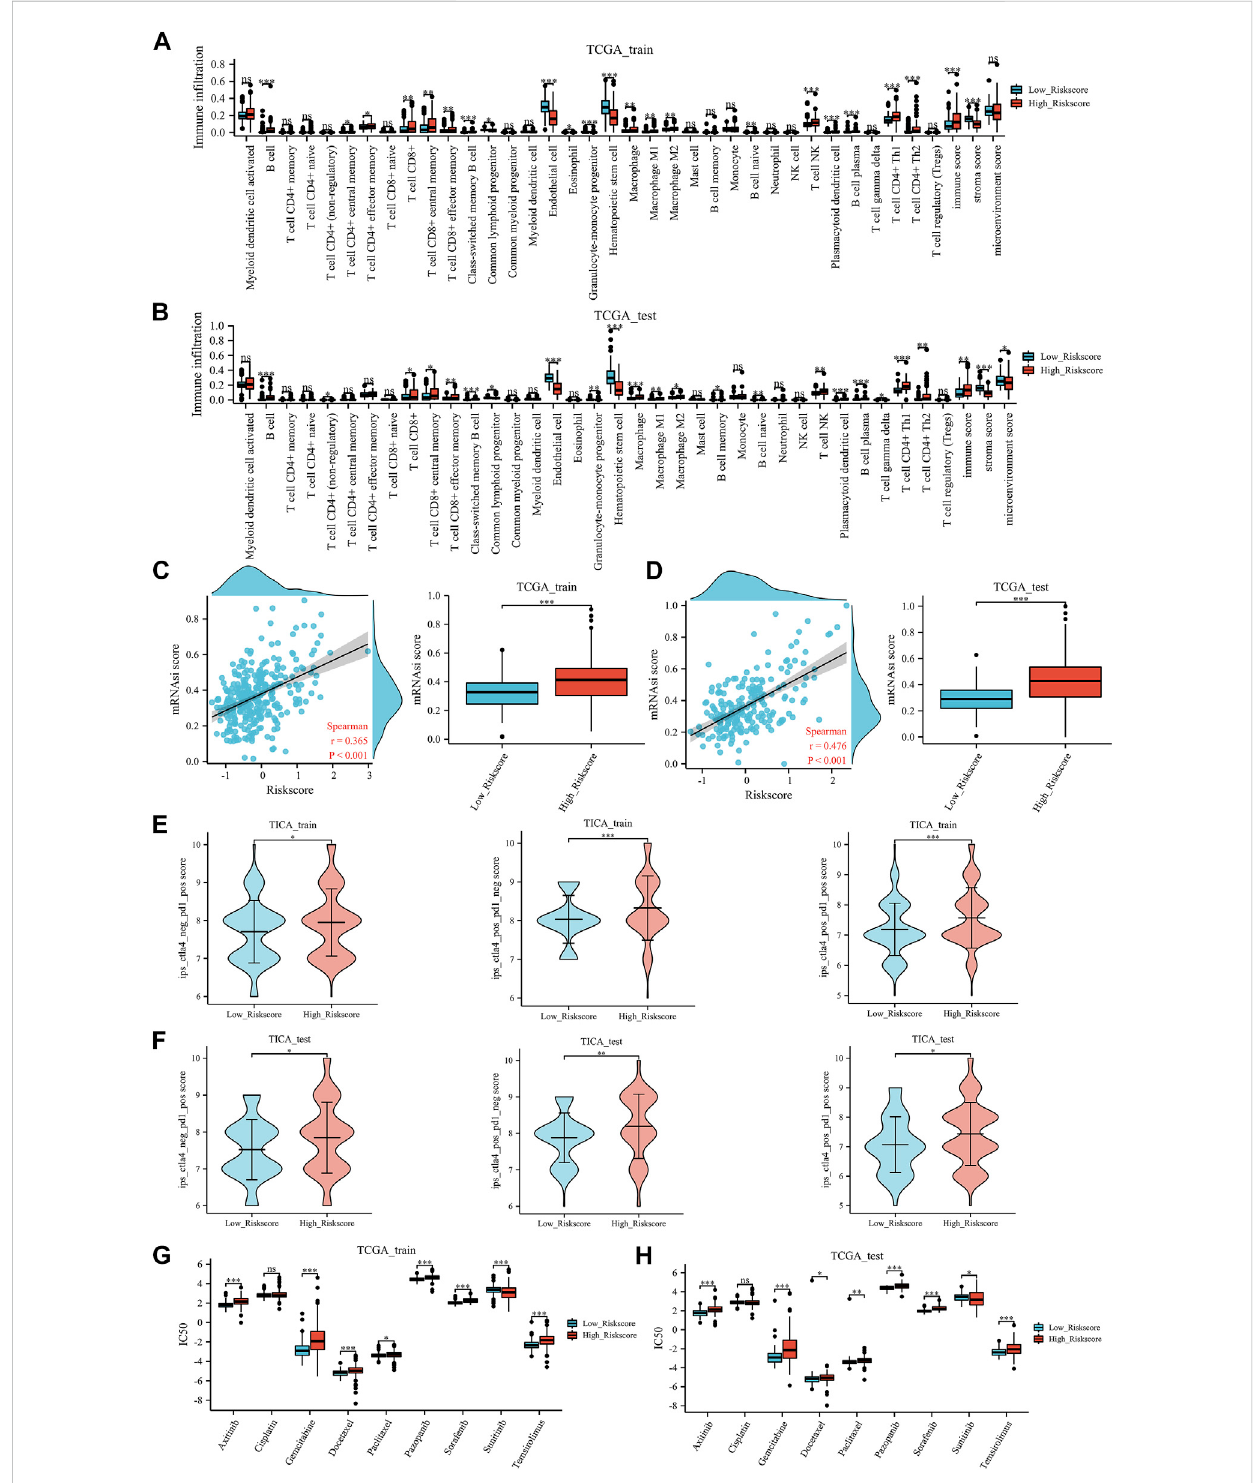
FIGURE 6 Immune-related analysis: the tumor microenvironment results of TCGA training group (A) and TCGA test group (B) , the stemness index results of TCGA training group (C) and TCGA test group (D) , the TCIA results of TCGA training group (E) and TCGA test group (F) , the prediction of chemotherapy and targeted therapy in TCGA training group (G) and TCGA testgroup (H) . mRNAsi: stemness index; IC50: the half-maximal inhibitory concentration. Ns, p ≥ 0.05; *, p < 0.05; **, p < 0.01; ***, p <